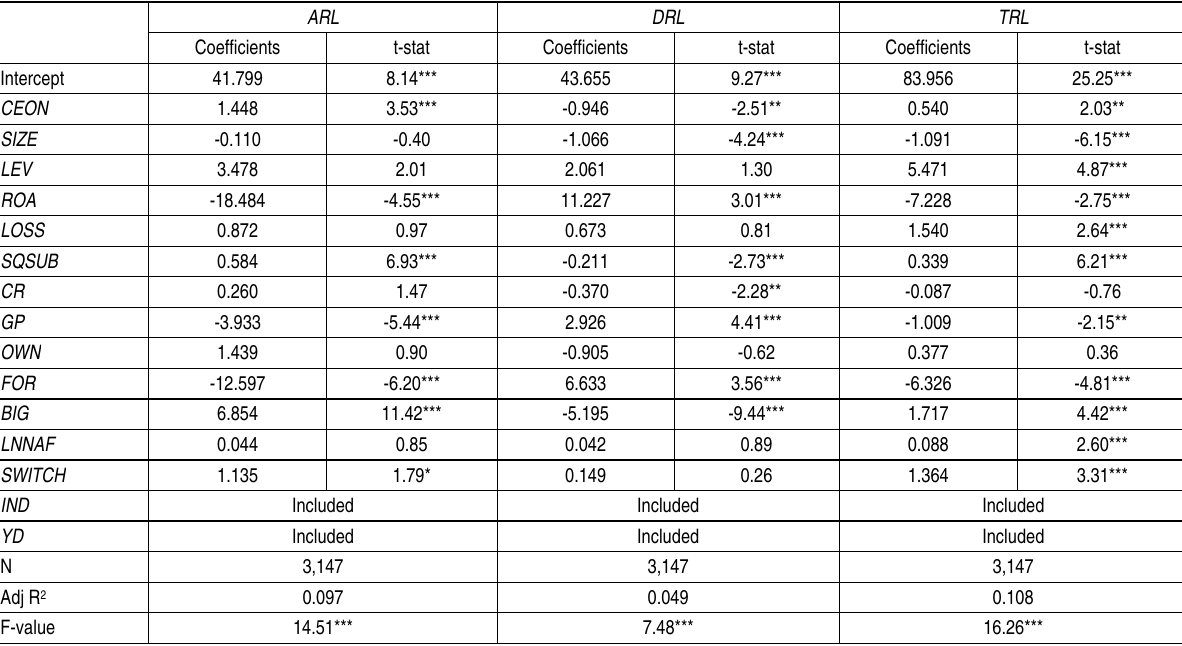
Table 3. Additional regression results – frequency of CEO